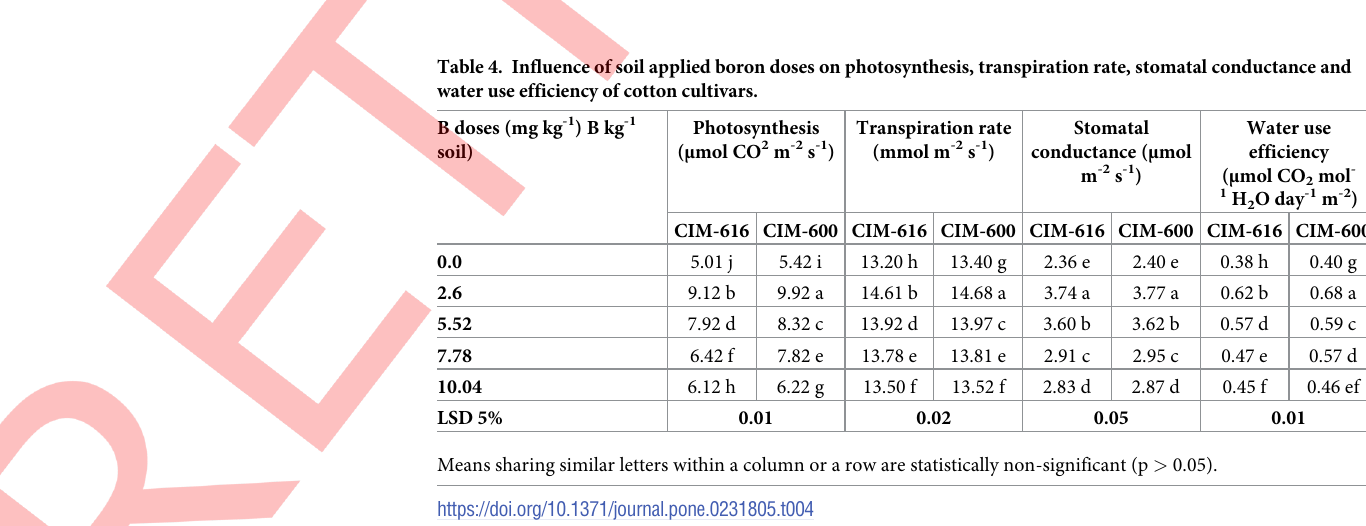
Table 4. Influence of soil applied boron doses on photosynthesis, transpiration rate, stomatal conductance and water use efficiency of cotton cultivars.